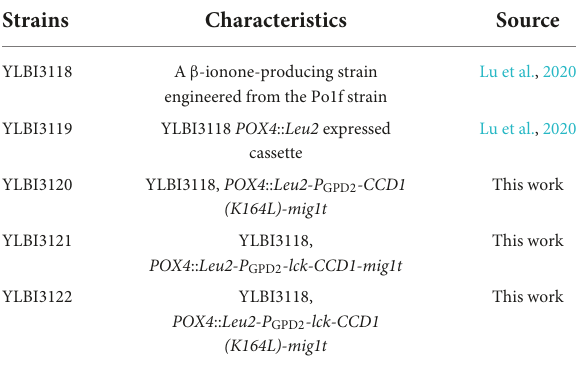
TABLE 2 Y. lipolytica strains used in this